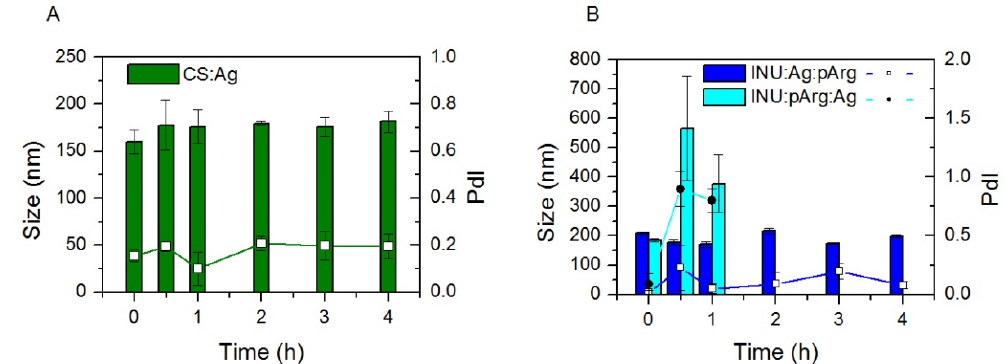
Figure 3. Stability of Imiquimod-loaded CS:Ag ( A ), INU:Ag:pArg, and INU:pArg:Ag ( B ) nanocapsules on RPMI culture medium supplemented with 10% FBS and incubated at 37 ◦ C. Graphs represent the size (bars) and PdI (lines and symbols) vs. time of incubation. Ag: Antigen, CS: Chitosan, FBS: fetal bovine serum, INU: Inulin, pArg: Polyarginine.